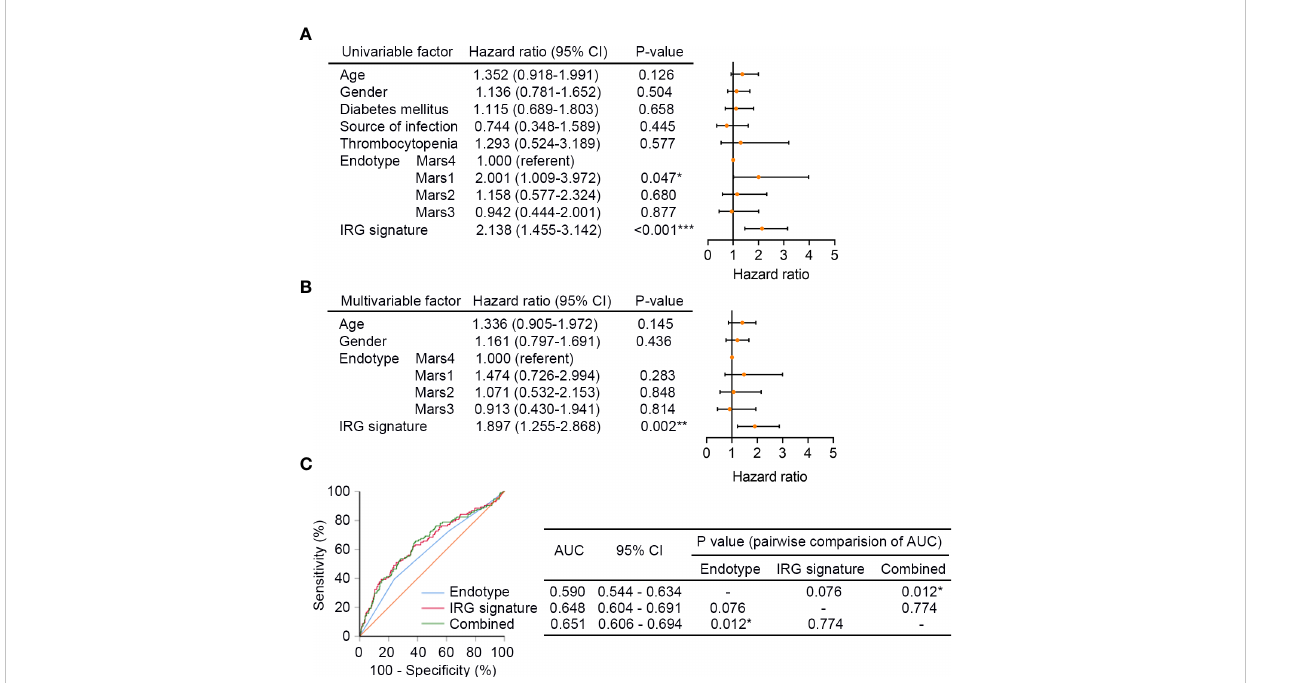
FIGURE 5 The IRG signature is an independent prognostic factor of sepsis. (A) The univariate Cox regression analysis performed on sepsis patients in GSE65682 (n = 479). Orange solid dots represent the hazard ratio of death and open-ended horizontal lines represent the 95% con fi dence intervals (CIs). All P values were calculated using Cox proportional hazards analysis. (B) The multivariate Cox regression analysis performed on sepsis patients in GSE65682 that contained age, gender, Mars endotype, and IRG signature as covariates. (C) ROC analysis of the sensitivity and speci fi city of 28-day survival prediction by the IRG signature risk score, Mars endotype, and combination of the two factors. P values were obtained from the comparisons of the AUC of the Mars endotype versus those of the IRG signature risk score and Mars endotype combined with the IRG signature risk score. *P < 0.05, **P < 0.01, ***P < 0.001. Mars, molecular diagnosis and risk strati fi cation of